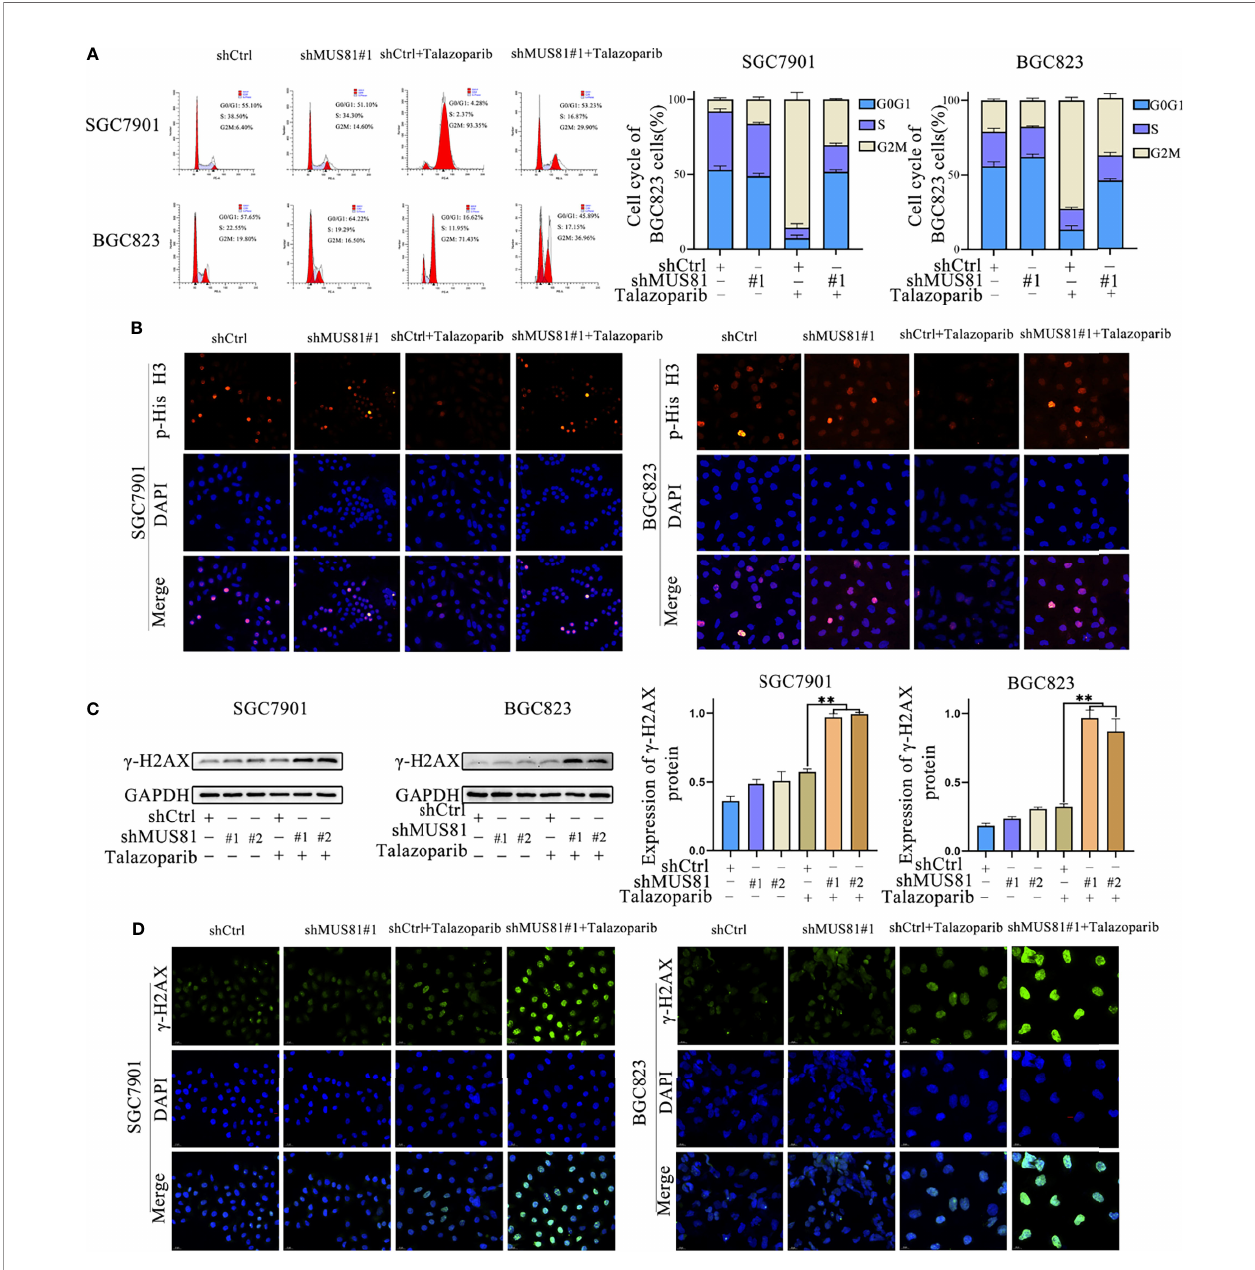
FIGURE 3 | MUS81 inhibition may increase talazoparib-induced DNA damage in gastric cancer cells. (A) Cells treated with DMSO or talazoparib (1 µmol/L) for 3 d to evaluate cell cycle distribution by fl ow cytometry ( t -test). ** P < 0.01. (B) Immuno fl uorescence to detect the expression of p-Histone H3 (Ser10) in DMSO or talazoparib-treated (0.5 µmol/L) cells for 2 d. Magni fi cation, 400×. (C) Western blot analysis of g -H2AX expression after treatment with 0.5 µmol/L talazoparib for 24 h (t-test). ** P < 0.01. (D) Immuno fl uorescence to detect the expression of g -H2AX in DMSO or talazoparib-treated (0.5 µmol/L) cells for 2 d. Magni fi cation, 400×. ** P <